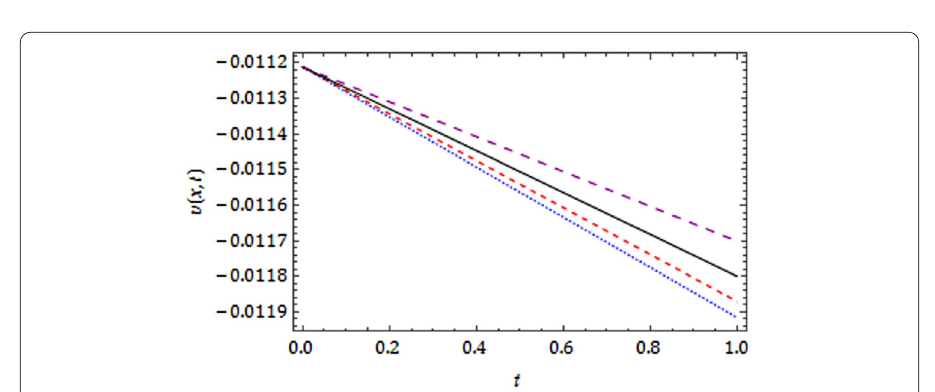
Figure 6 Nature of v ( x , t ) with distinct (cid:2) at ω = 0.005, (cid:13) = 0.1, c = 10, n = 1, α = 1 and x = 1 for Example 6.1